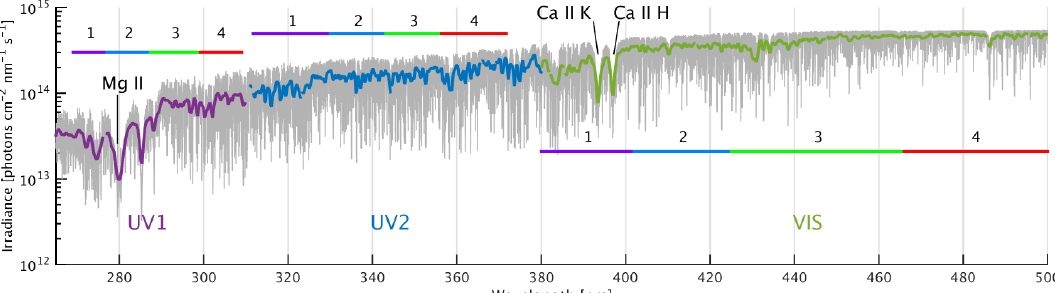
Figure 1. Solar irradiance spectra observed by the UV1, UV2, and VIS bands of OMI (overlapped spectral regions are not shown). The background high-resolution solar reference spectrum in gray is from Dobber et al. (2008). Deep solar lines used to monitor solar activity are labeled. The colored horizontal bars indicate the spectral windows within which slit functions are fitted in Sect.